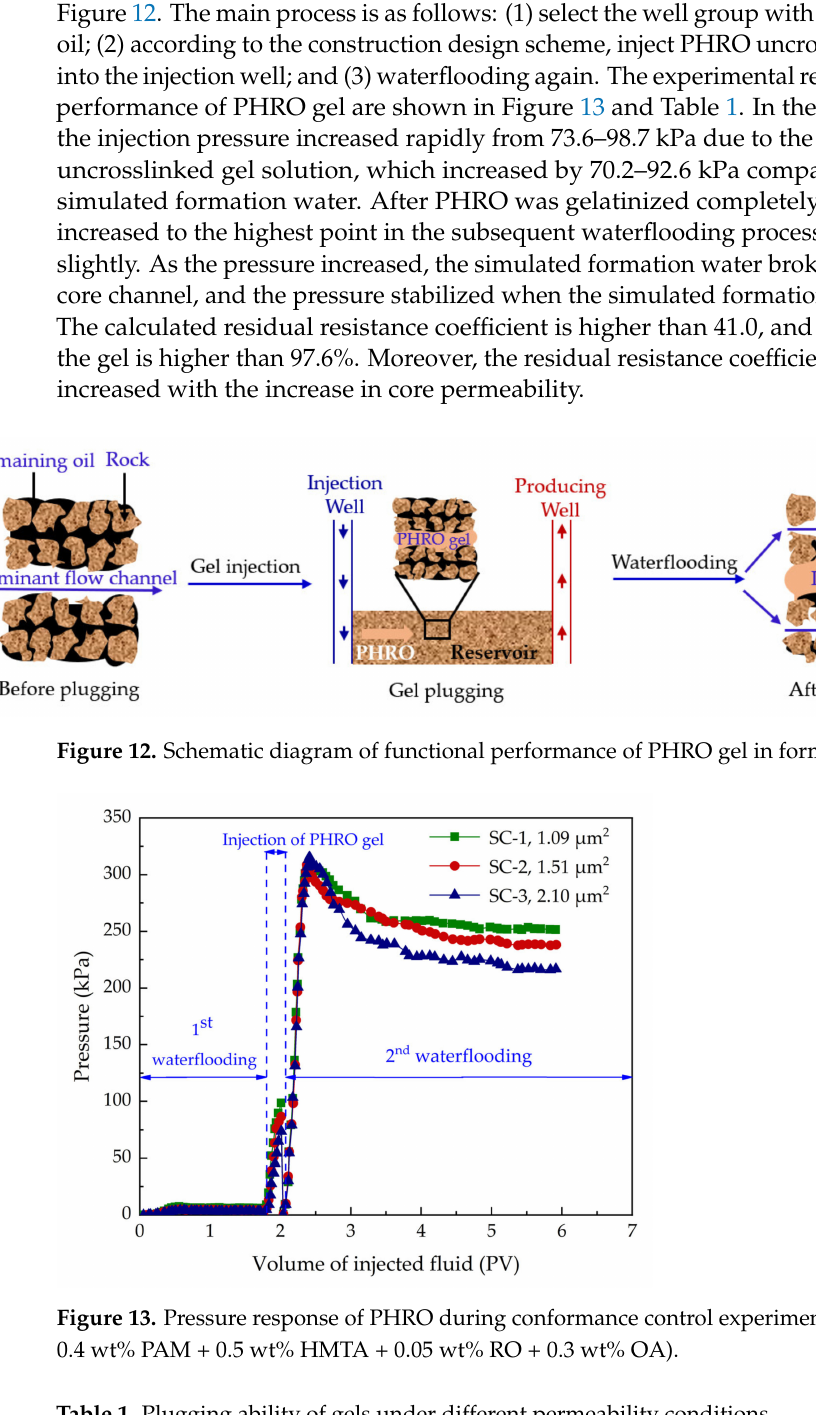
Table 1. Plugging ability of gels under different permeability